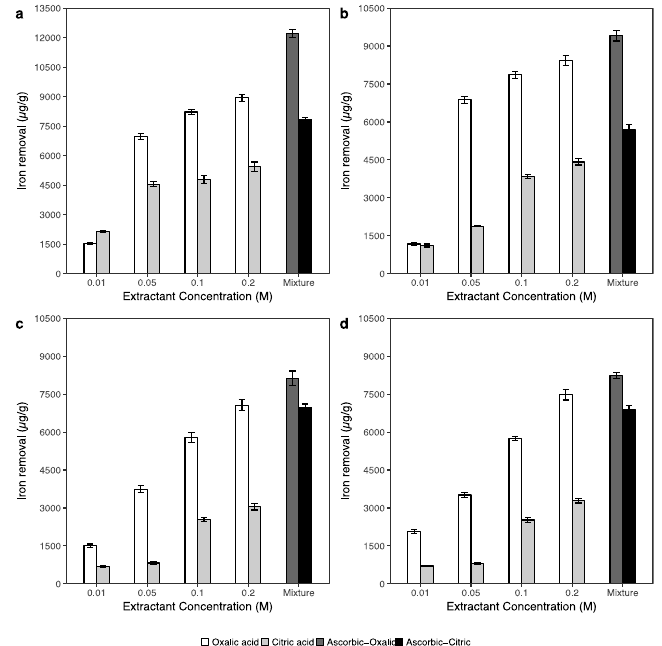
Figure 4. Extracted iron under the effect of oxalic and citric acid in various concentrations (from 0.01 M to 0.2 M), and the combination of 0.1 M ascorbic with 0.2 M oxalic acid, and the combination of 0.1 M ascorbic with 0.2 M citric acid in river bed sediment ( a ), mangrove forest soil ( b ), paddy soil ( c ) and aquaculture farm sediment ( d ).